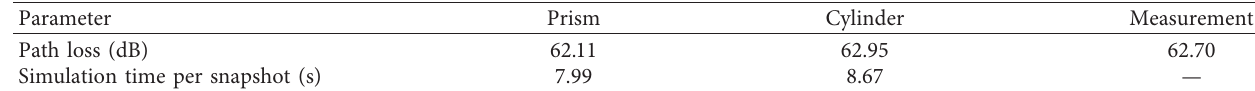
Figure 13: CDFs of the PL with the Rx on the right upper arm. Table 13: Simulation and measurement results around the arm.